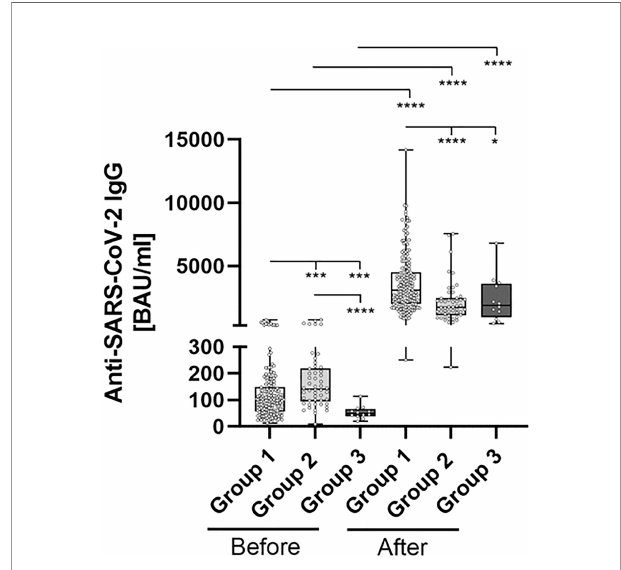
FIGURE 2 | Comparative determination of anti SARS-CoV-2 IgG binding antibodies before and after third booster vaccination with BNT162b2. To evaluate differences between vaccination-strategies, participants were grouped into 3 cohorts: Group 1: three vaccine-doses of BNT162b2; Group 2: initially two vaccine-doses of ChAdOx1 and BNT162b2 booster-dosage; Group 3: heterologous vaccination-protocol (ChAdOx1+ BNT162b2) and BNT162b2 booster-dosage. Anti-SARS-CoV-2-IgG binding antibodies were determined before and 4 weeks after third booster-dosage using a quantitative assay from Abbott. In keeping with the WHO-standard, data were expressed in Binding Antibody Units per ml (BAU/ml). Samples were marked seronegative below 7.1 BAU/ml whereas values above or equal to 7.1 BAU/ ml were determined to be positive, as mentioned by the manufacturer. *p < 0.05; ***p < 0.001; ****p < 0.0001 (Mann-Whitney